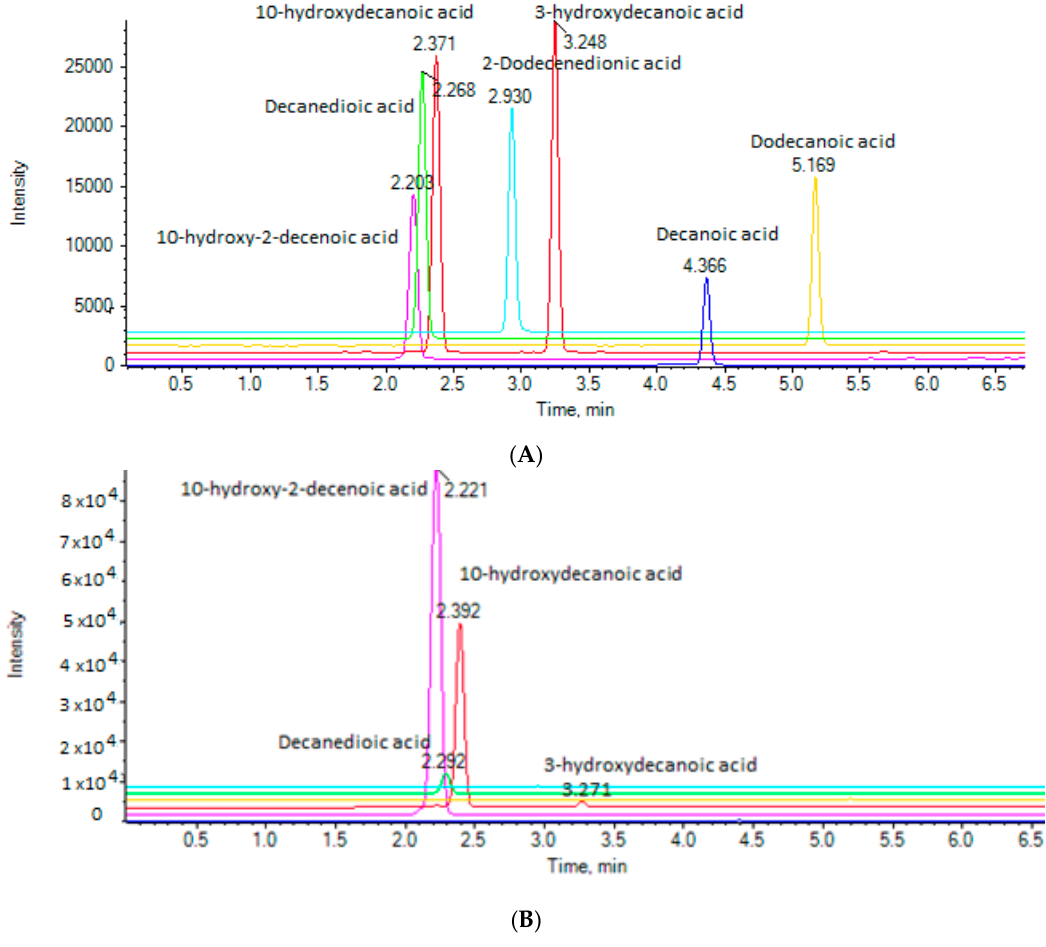
Figure 2. Extracted ion chromatograms (EICs) of the analytes in ( A ) a standard solution (500 ng / mL); and ( B ) a RJ sample (500-fold